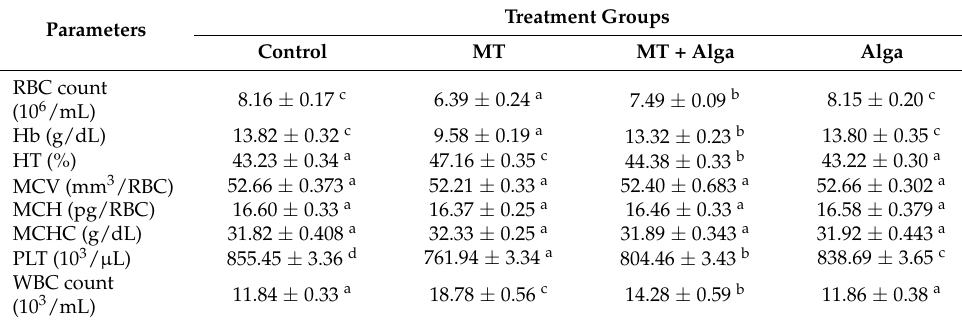
Table 3. Effect of daily administration of MT and alga on hematological parameters in different experimental groups of